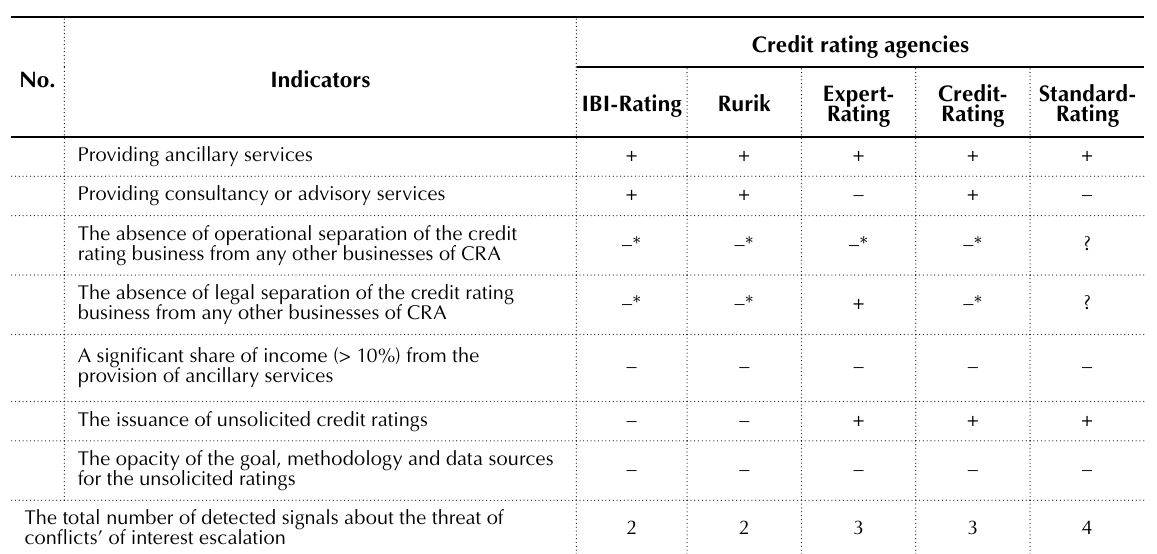
Table 2. The warning signals concerning the potential of conflicts of interest in models of business activities of CRAs in